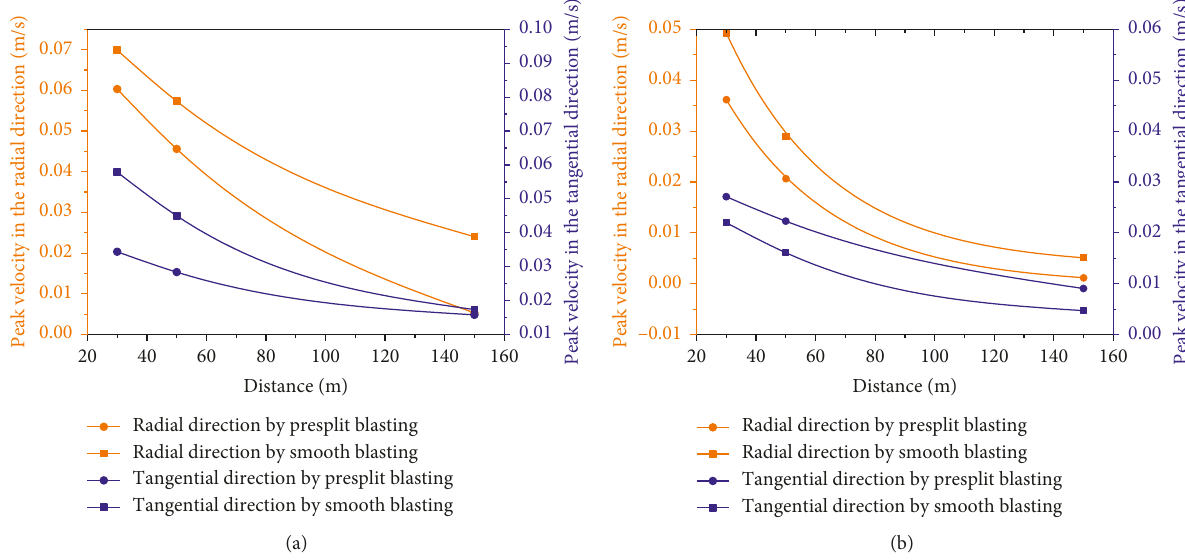
Figure 5: The variations of PPVs from (a) main and (b) peripheral boreholes versus distances in radius and tangential directions based on smooth and presplit